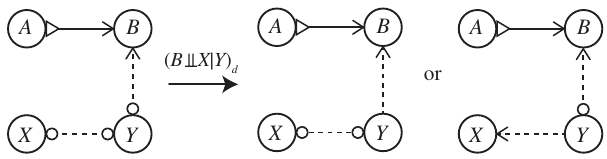
FIG. 10. DAG elimination from d -separation in step